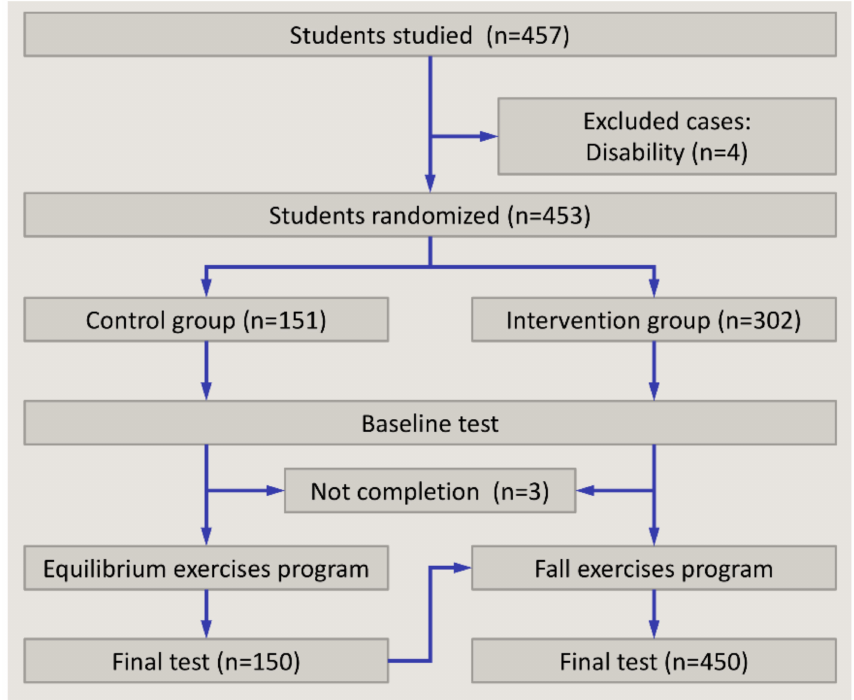
Figure 2. Students’ flow through